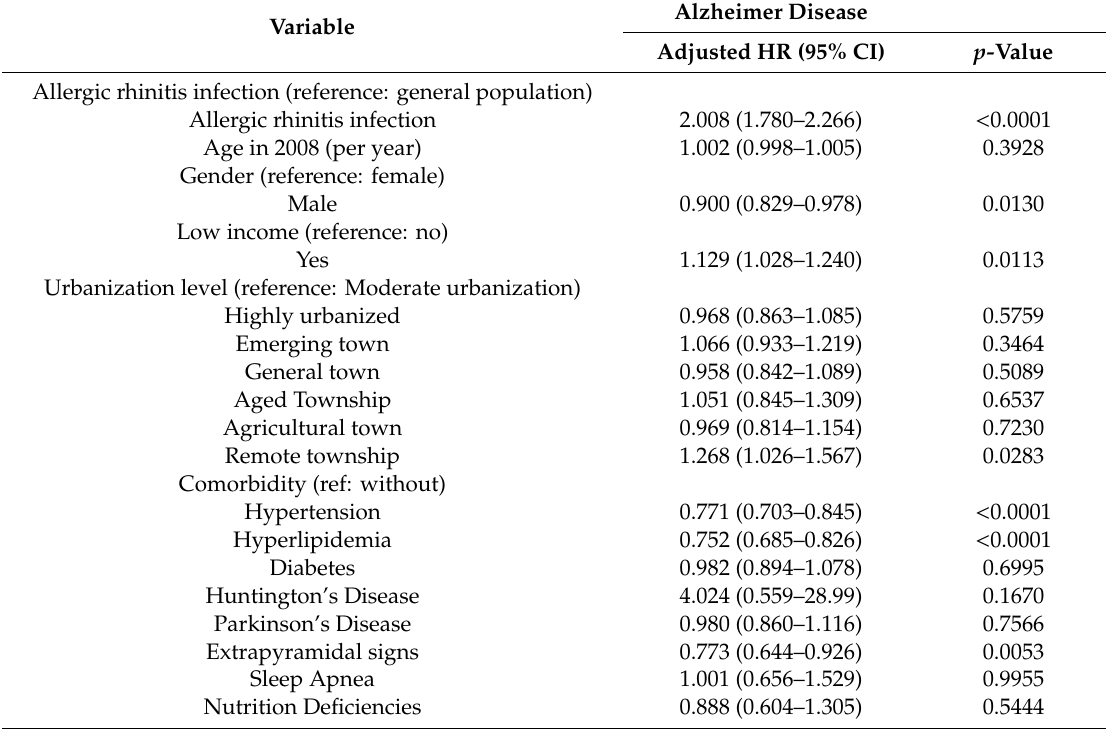
Figure 2. Kaplan–Meier curves estimating cumulative incidence of AD between patients in the AR and comparison cohorts. Table 2. The risks of patients with AR versus patients with AD without AR stratified by demographics in Cox proportional hazard regression.